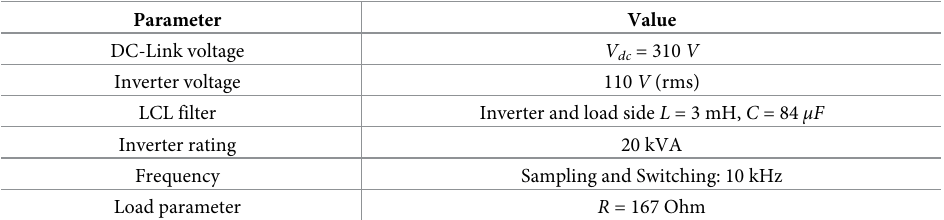
PLOS ONE | https://doi.org/10.1371/journal.pone.0270851 August 1,